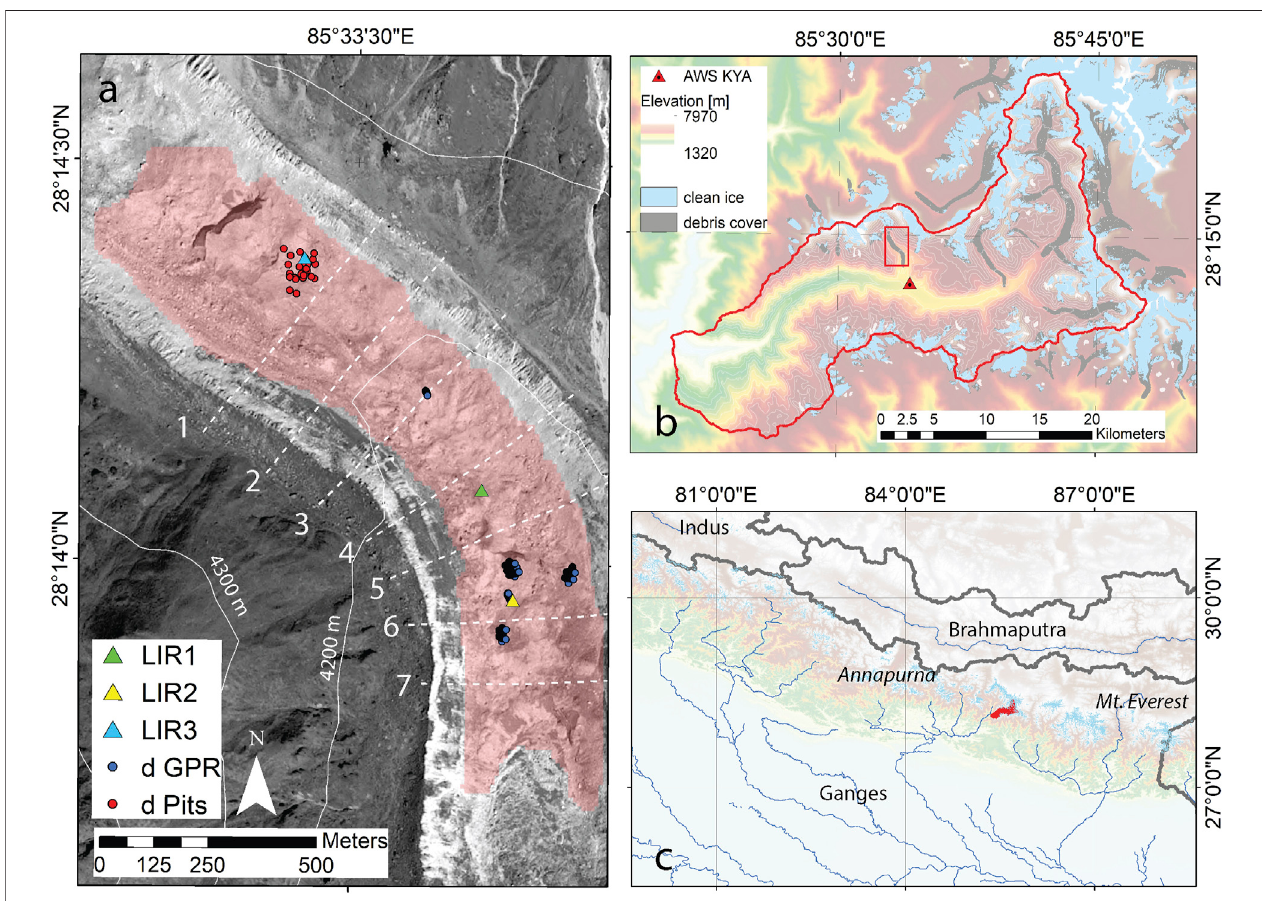
FIGURE 1 | (A) Overview map of the study site, showing the ablation tongue with the locations of atmospheric measurements (LIR1, LIR2, LIR3) as well as debris thicknessmeasurementsbyGPR(dGPR)andexcavation(dPits).Theredshadedareashowsthemodeldomainin2013,wheremasslossmeasurementsareavailable. Theimageshowsthepartofthetonguewherecontinuous debrisisobserved.Thewhitedashed linesshowthe fl uxgates(usedforthecalculationofemergencevelocity (see Supplementary Material ). (B) Langtang catchment,with all debris-covered glaciers shaded grey,and the location ofthe Kyanjing AWS (AWS KYA) south of Lirung Glacier. (C) Location of Langtang catchment in the Central Himalaya.